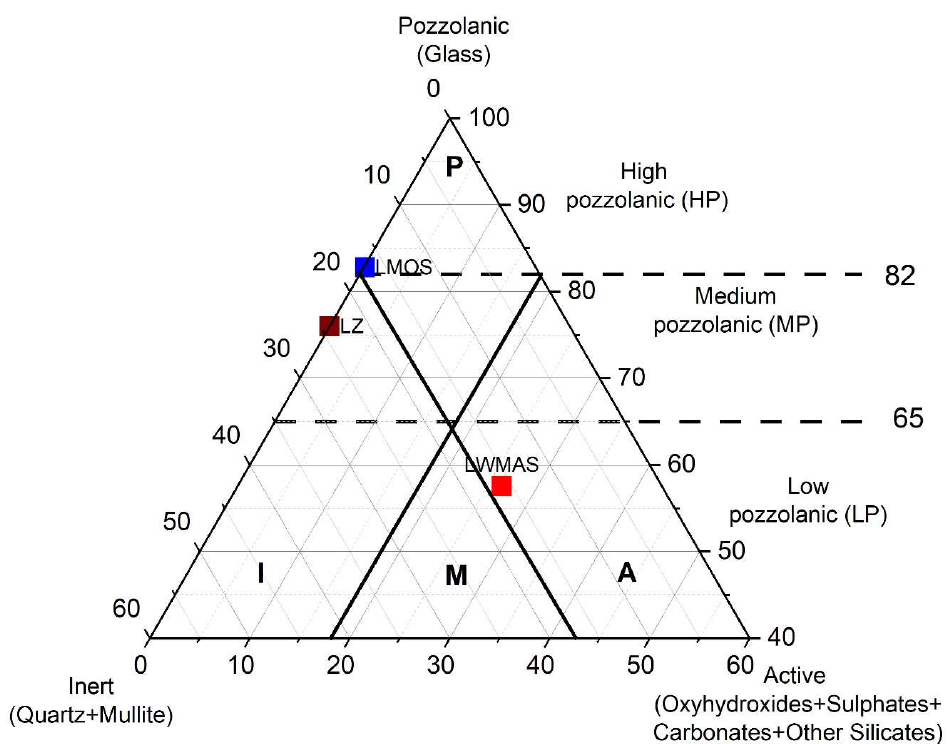
Figure 4. Positions of the tested samples in the Vassilev’s phase-mineral classification system [47].